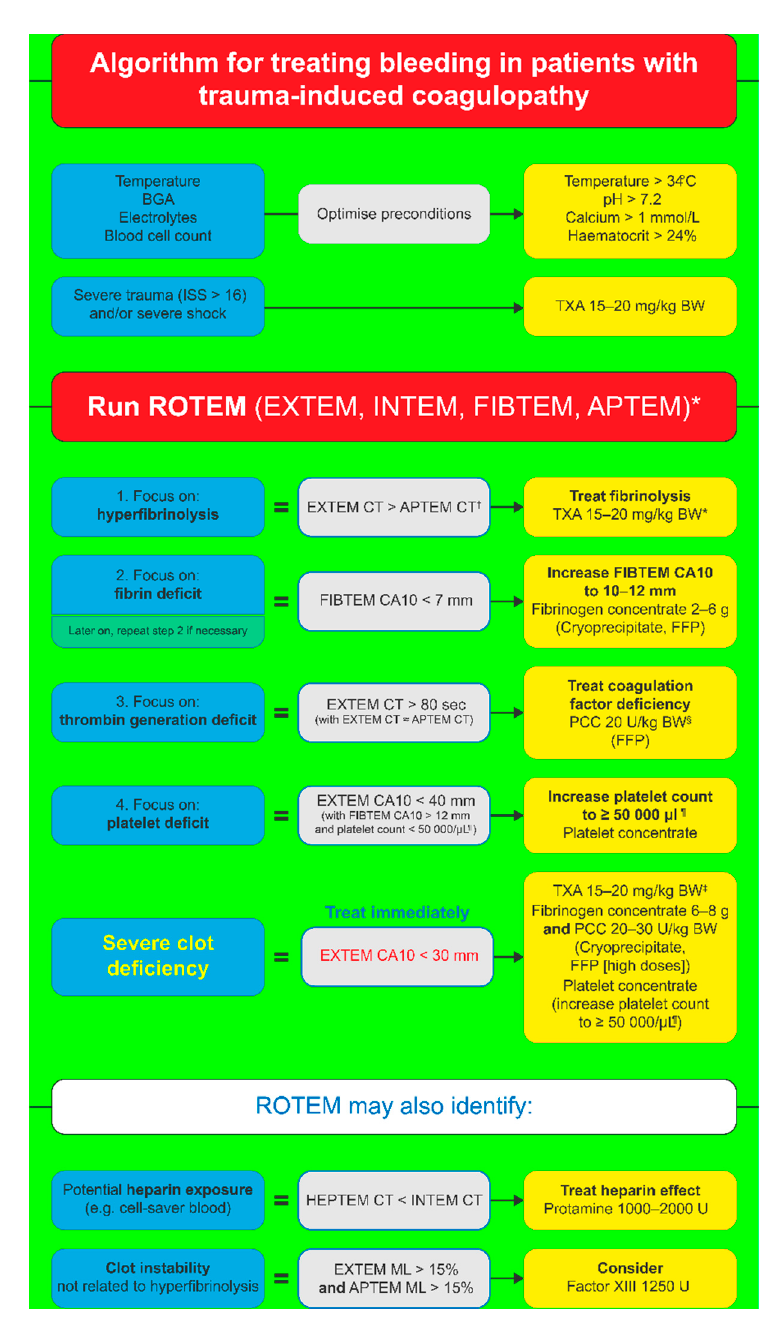
Figure 1. ROTEM-guided treatment algorithm for the management of trauma-induced coagulopathy. Adapted from Schochl et al., 2012 [6]. Reprinted from Springer Nature as indicated in the Terms and Conditions of the Creative Commons Attribution license. * For patients who are unconscious or known to be taking platelet inhibitor medication, Multiplate tests (adenosine diphosphate [ADP] test, arachidonic acid [ASPI] test, and thrombin receptor activating peptide-6 [TRAP] test) are also performed. † Any major improvement in APTEM parameters compared to corresponding EXTEM parameters may be interpreted as a sign of hyperfibrinolysis. ‡ Only for patients not receiving TXA at an earlier stage of the algorithm. § If decreased ATIII is suspected or known, consider co-administration of ATIII. ¶ Traumatic brain injury: platelet count 80,000-100,000/ μ l. CA 10 , clot amplitude at 10 min; BGA, blood gas analysis; BW, body weight; CT, clotting time; FFP, fresh frozen plasma; ISS, injury severity score; MCF, maximum clot firmness; ML, maximum lysis; PCC, prothrombin complex concentrate; TXA, tranexamic acid.